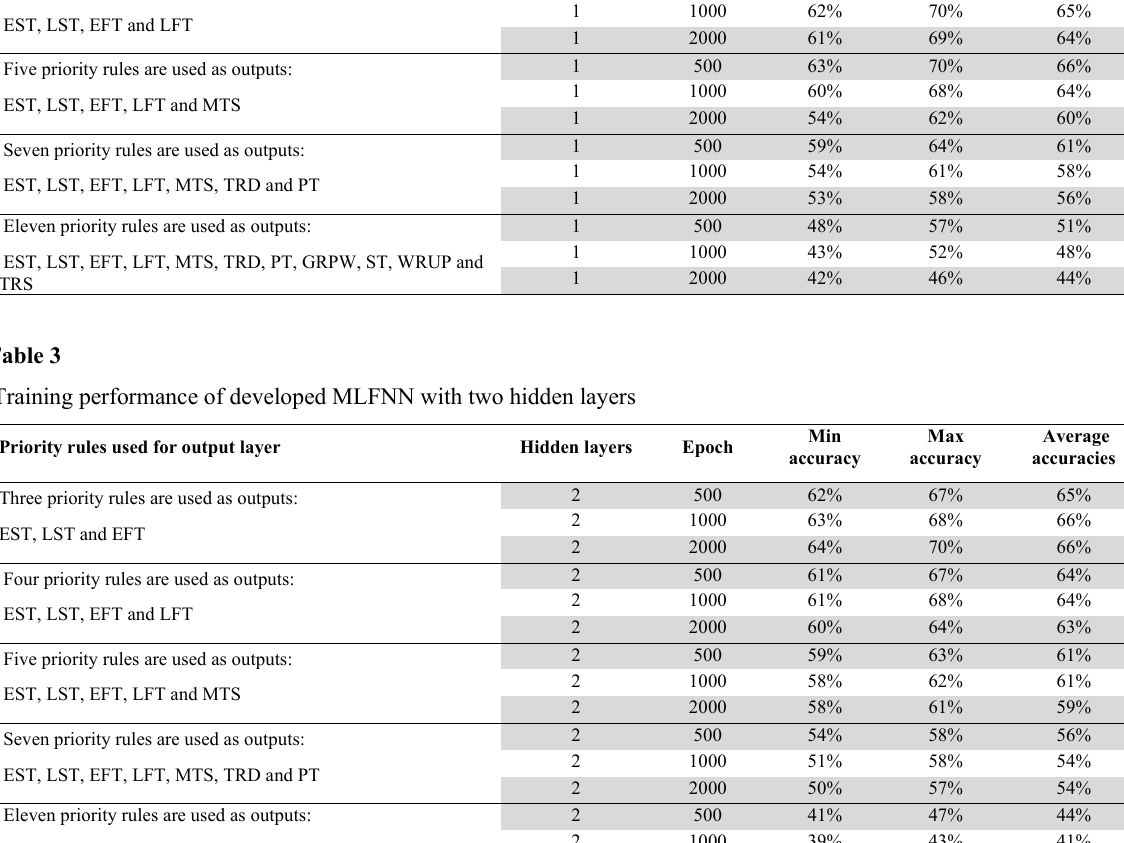
Min Max Average accuracy accuracy accuracies